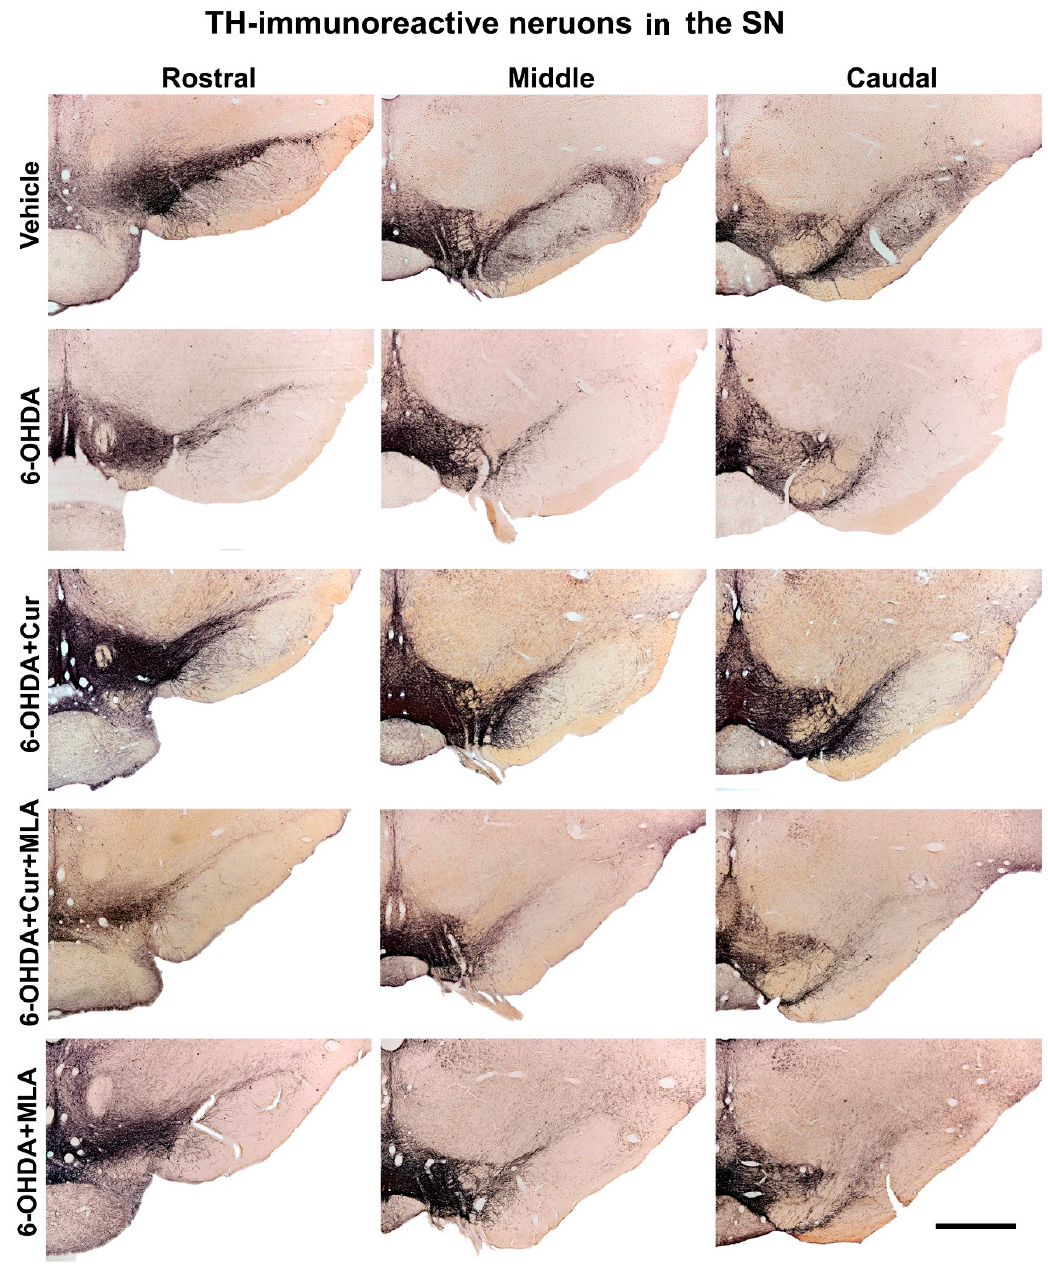
Figure 4. Photomicrographs of coronal sections of the midbrain showing TH immunoreactivity in three rostro-caudal levels of substantia nigra (SN) on the lesion sides. In comparison with the vehicle treatment, 6-OHDA-treated rats exhibited severe loss of TH-positive cells in the substantia nigra pars compacta (SNpc) at all levels. Curcumin-treated rats displayed significant improvements in cell survival in comparison with 6-OHDA-injected rats. MLA, an α 7-receptor blocker, reversed the protective effect of curcumin in the 6-OHDA+Cur+MLA group. The MLA antagonist had no effect by itself, however, as indicated by the last animal group, 6-OHDA+MLA, which exhibited no statistical difference from the 6-OHDA+Cur+MLA group or 6-OHDA-injected rats. Scale bar = 1 mm.